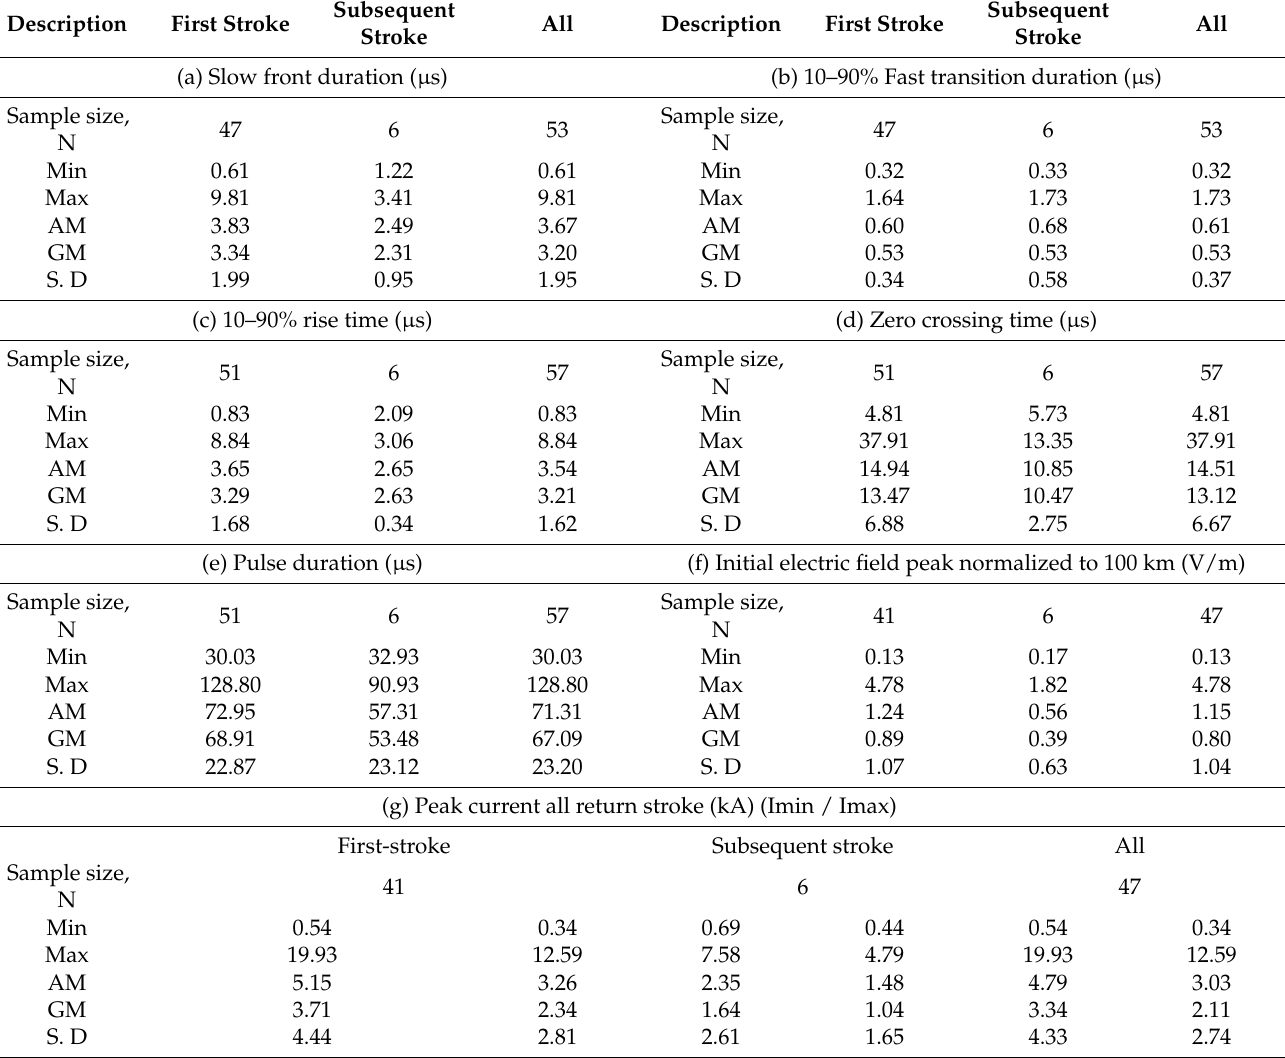
Table A1. Comparison of +CG flash parameters for first, subsequent and all return strokes in